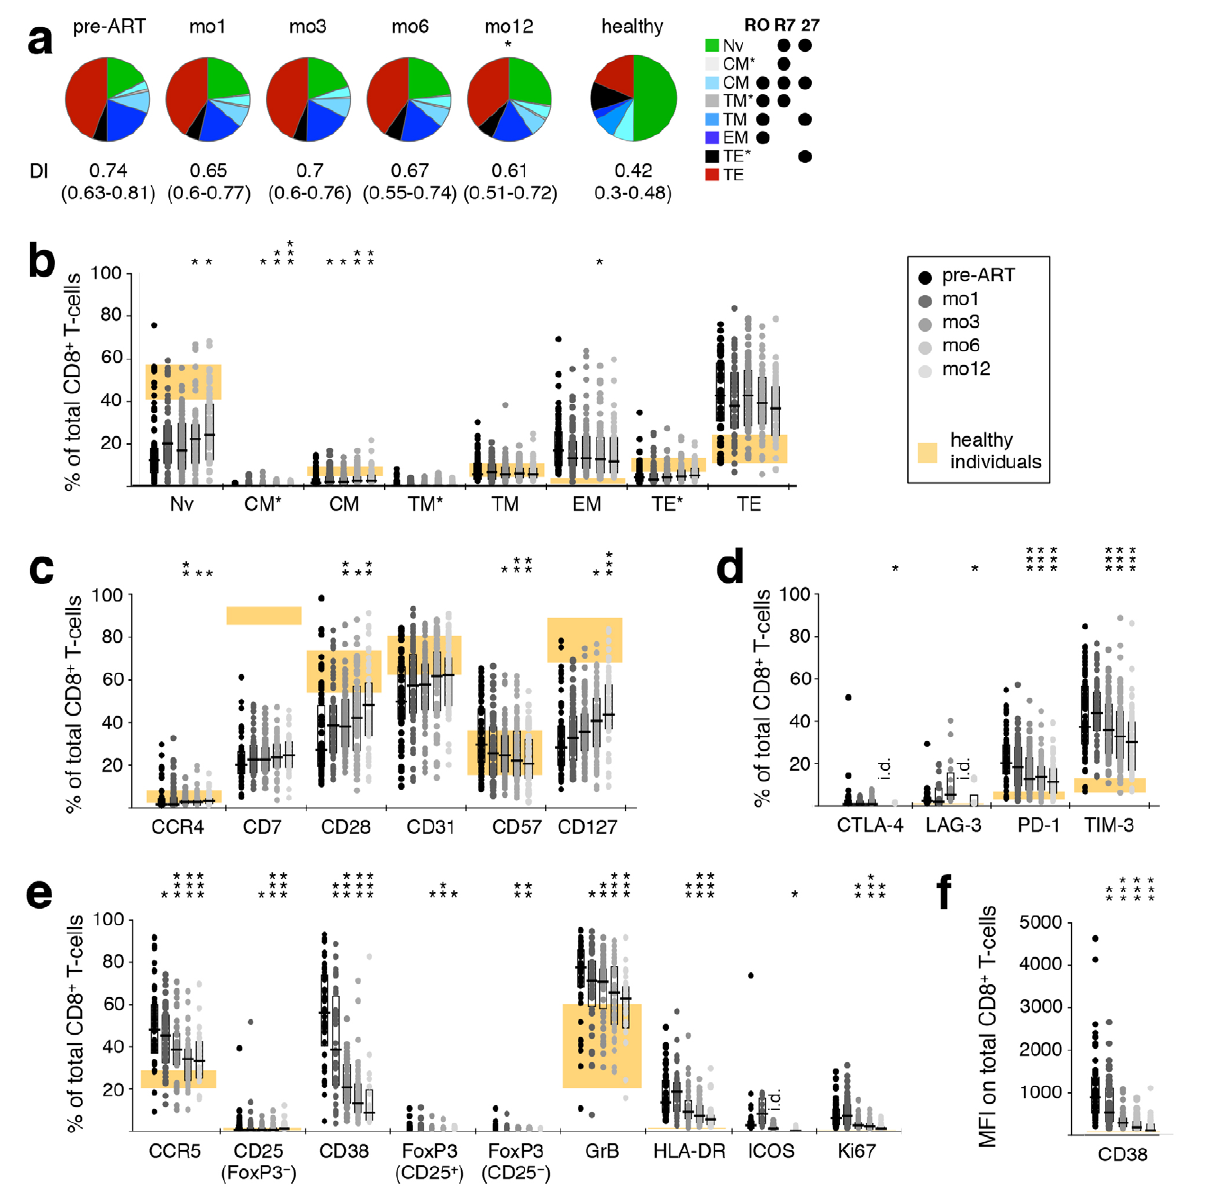
Supplementary Figure 2. ART-induced change towards less differentiated CD8 + T cells. PBMC were sampled before, as well as after 1, 3, 6, and 12 months of ART. The distribution of differentiation stages (A) and frequency of individual differentiation subsets (B) was investigated in CD8 + T cells. T-cell differ- entiation subsets were defined by expression of CD45RO (“RO”), CCR7 (“R7”) and CD27 (“27”). Differ- entiation indices (DI; medians and interquartile ranges) are indicated next to each pie. The average T-cell differentiation profile as well as the interquartile range of the differentiation indices in healthy donors are shown. (C) Markers of Tcell differentiation. (D) Inhibitory receptors. (E) Markers of activation; GrB– Granzyme B. (F) Mean fluorescence intensity of CD38. Graphs show interquartile ranges, median bars, as well as individual data points. Orange areas represent the interquartile ranges of corresponding measure- ments in healthy individuals. All timepoints were compared to corresponding pre-ART measurements: * P < 0.01, ** P < 0.001, *** P <